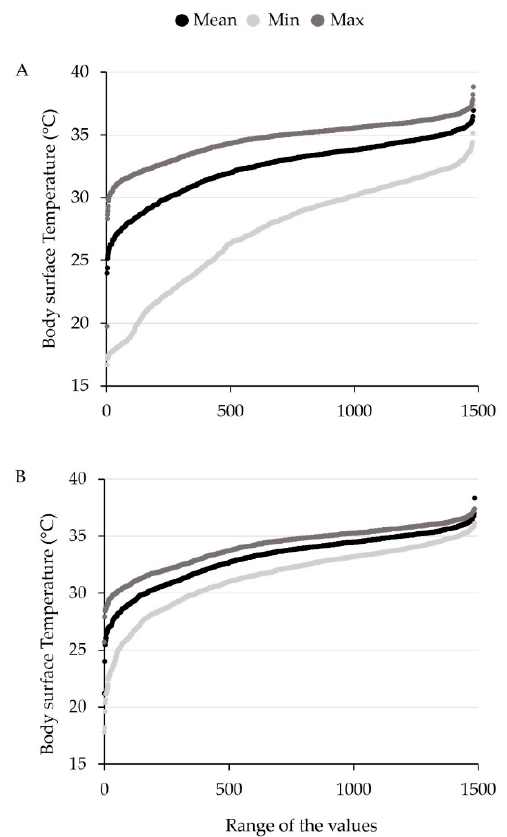
Figure 4. Cumulative distribution of all measured values for minimum, mean, and maximum body surface temperature (°C) for evaluation method ME ( A ) and SC ( B ).